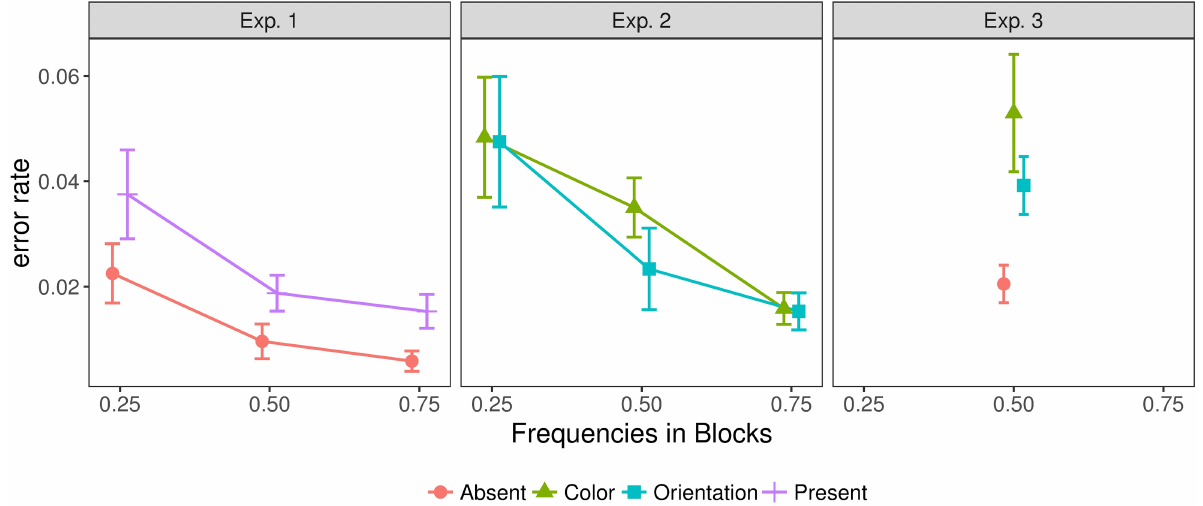
Fig 2. Error rates in Experiments 1, 2, and 3, for all combinations of target frequency. Target frequency is defined relative to the target condition, as the frequency with which that target condition occurred within a given block. This means that, for a given frequency, the data from the different target conditions do not necessarily come from the same block of the experiment. Error bars show the standard error of the mean. https://doi.org/10.1371/journal.pcbi.1006328.g002 ¼ 0 : 51 ; BF ¼ 75 . In contrast, there was no difference in error F ð 1 ; 11 Þ ¼ 11 : 43 ; p < 0 : 01 ; Z 2 p rates between color and orientation targets in Experiment 2, F (1,11) = 0.70, p = 0.42, BF = 0.33. In Experiment 3, there was no manipulation of target (or dimension) frequency, but like in Experiment 1, error rates were higher on target-present than on target-absent trials, t (11) = 4.25, p < 0.01, BF = 30.7; and similar to Experiment 2, there was no significant difference in error rates between color and orientation targets, t (11) = 1.51, p = 0.16, BF = 0.71.